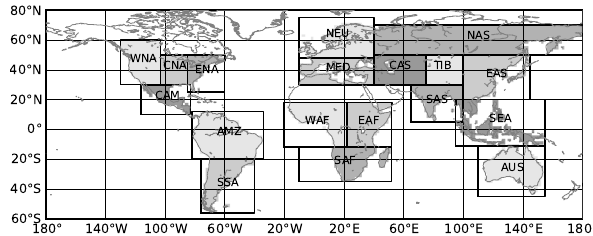
Figure 2. Regions used in the analysis adapted from Giorgi and Francisco (2000). See also Table